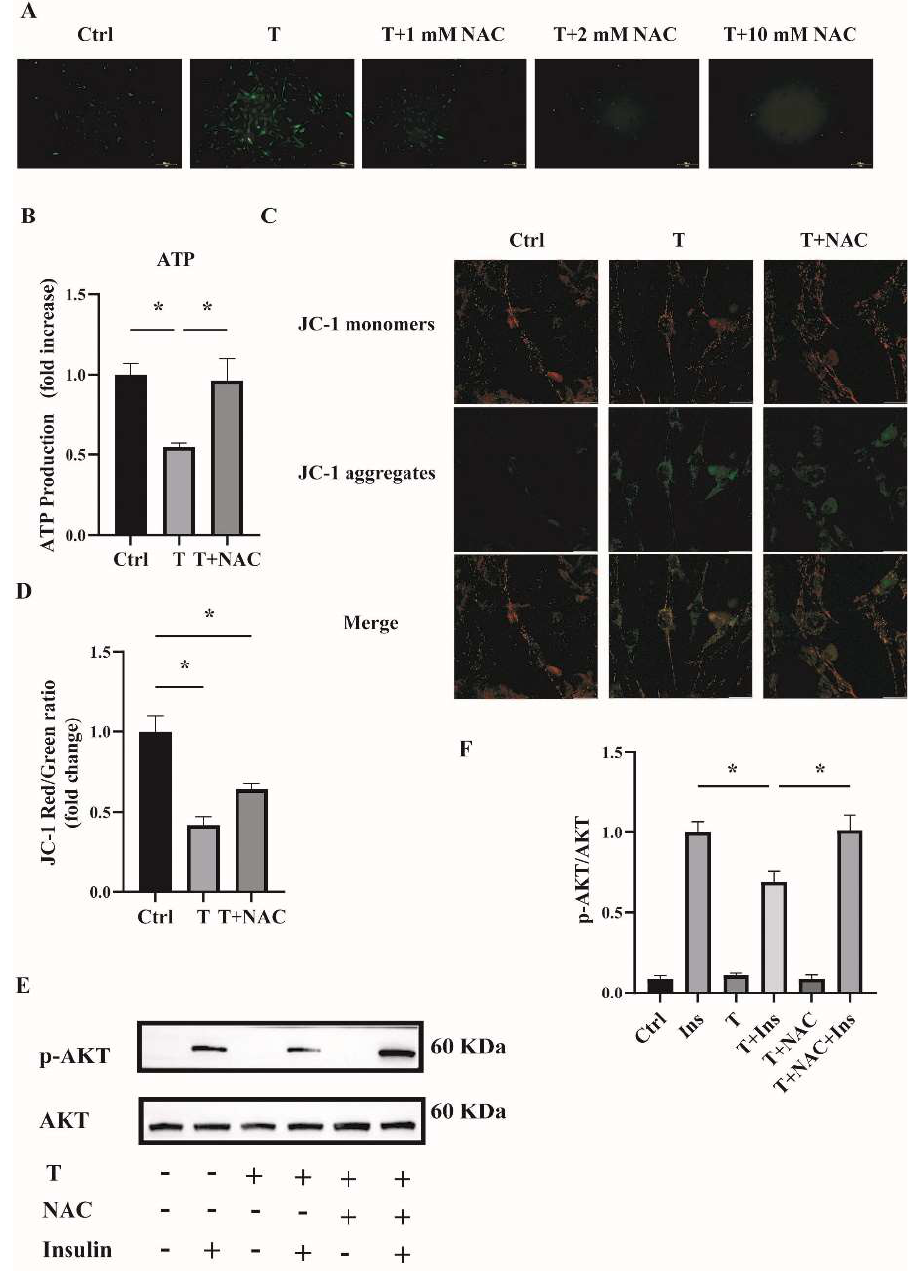
Figure 7. Effects of NAC intervention on T-treated C2C12 cells. ( A ) Representative photomicrographs of intracellular ROS in C2C12 cells. Fully differentiated C2C12 cells were treated with T (0, 10 − 5 M) or the combination of T (10 − 5 M) with NAC (1, 2, and 10 mM) for 12 h. Then, intracellular ROS was determined by DCFH-DA staining. Scale bar= 200 µ m. ( B ) Normalized ATP production. Fully differentiated C2C12 cells were treated with T (0, 10 −5 M) or T (10 −5 M) plus NAC (1 mM) for